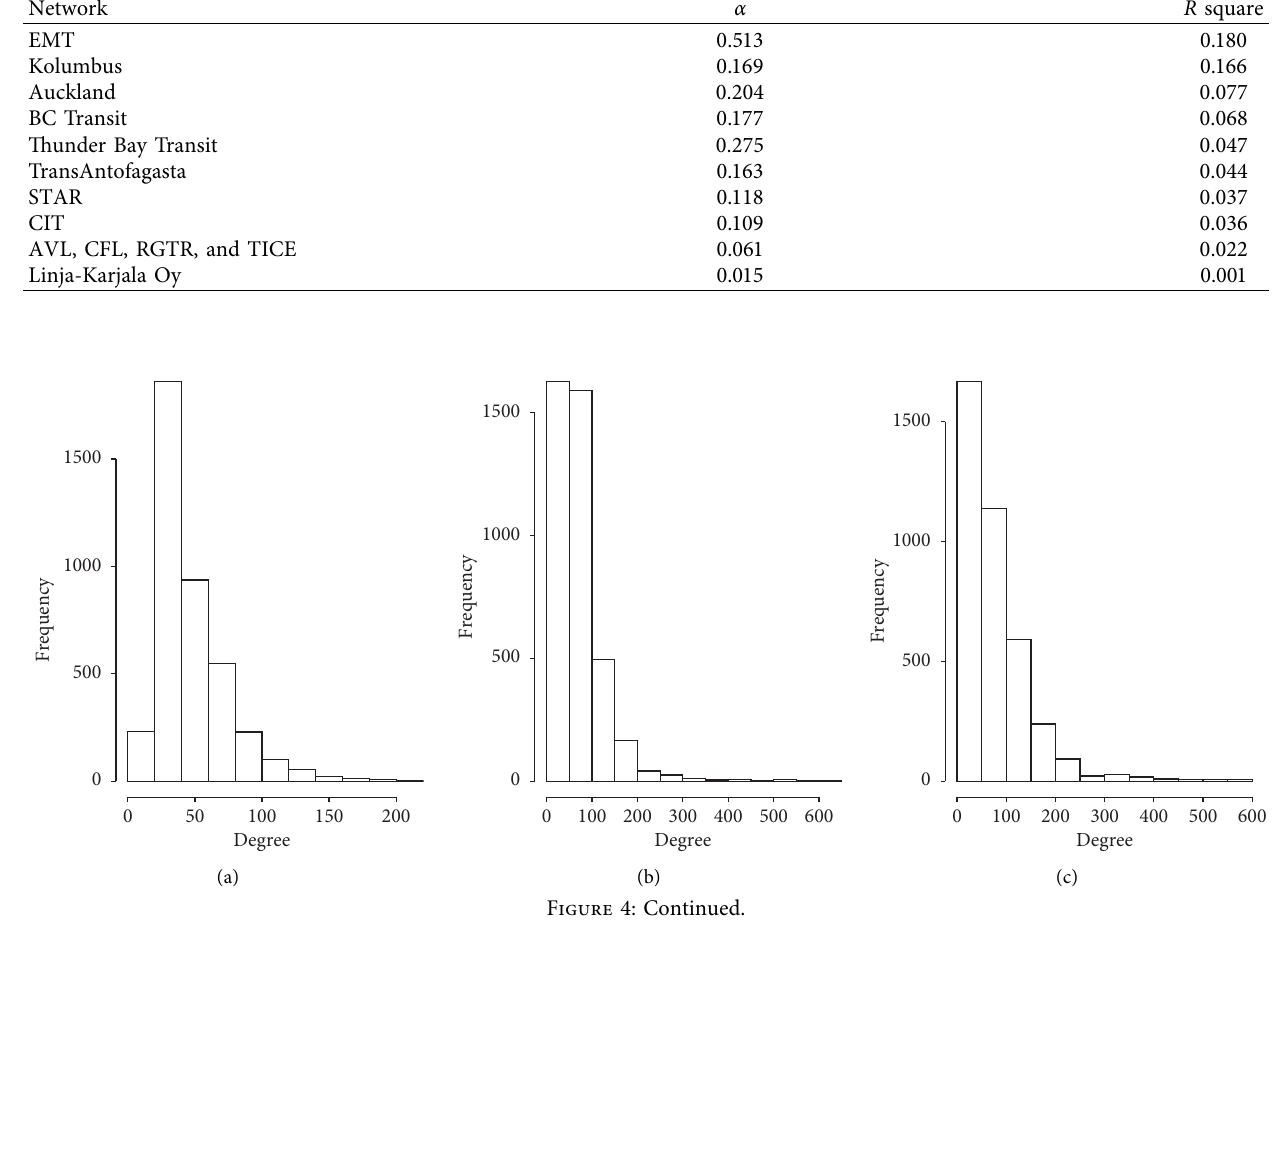
Table 6: Fitting in P-Space of the network degree distribution to a power law